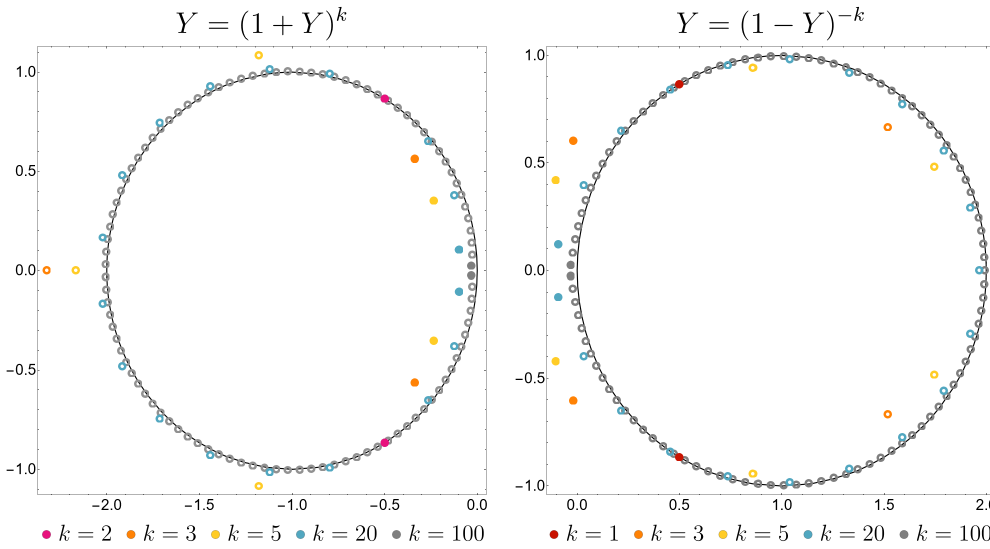
Figure 8. Constant solutions to equations (4.21) in the complex plane, where k labels the number of resonances and Y are the constant Y -functions Y = e − (cid:15) in the ultraviolet. There are k solutions to the fermionic equations (left) and k +1 to the bosonic ones (right). The filled circles identify the pair of solutions chosen by the TBA. In the k → ∞ limit, the solutions condense into the circles centered at Y = ∓ 1 , depicted in black. In this limit the TBA gives Y → 0 for both bosonic and fermionic equations, resulting in ˜ c = 0 in the